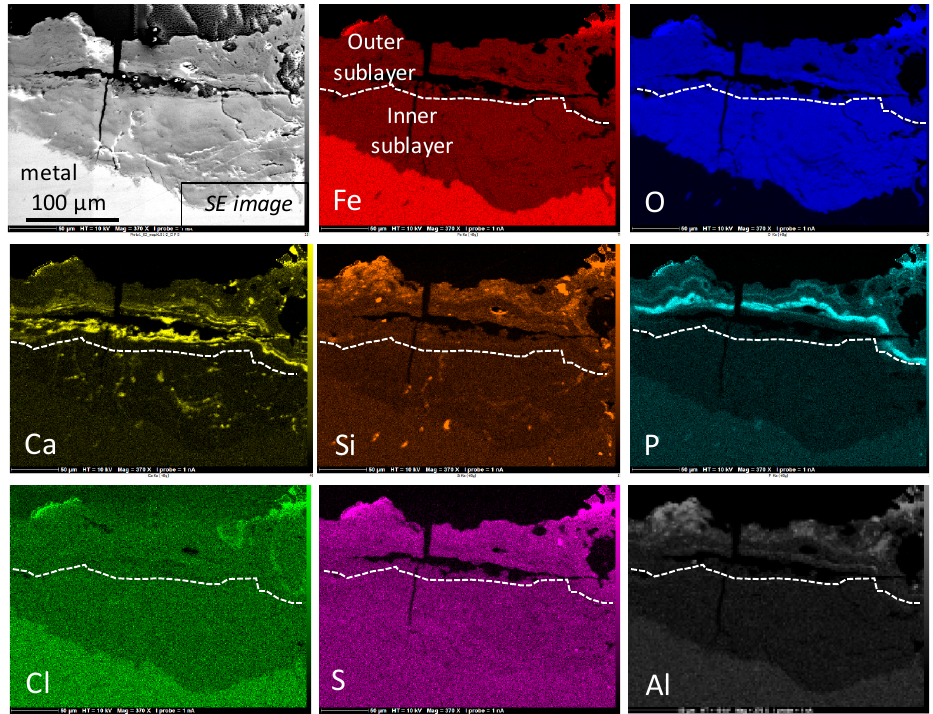
Figure 4. FESEM image of the corrosion product layer in the backscattered electron mode, and related EDS maps (K α lines) of detected chemical elements. The white dot line corresponds to the limit between the inner and outer sublayers of the corrosion product layer.